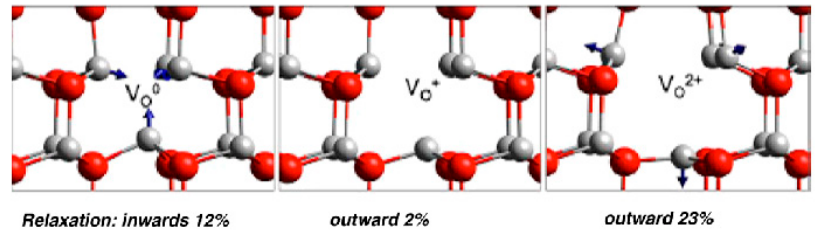
Figure 10. Ball and stick representation of the local atomic relaxations around the oxygen vacancy in ZnO in the (0), (1 + ), and (2 + ) charged states. Reproduced with permission from Seebauer and Kratzer